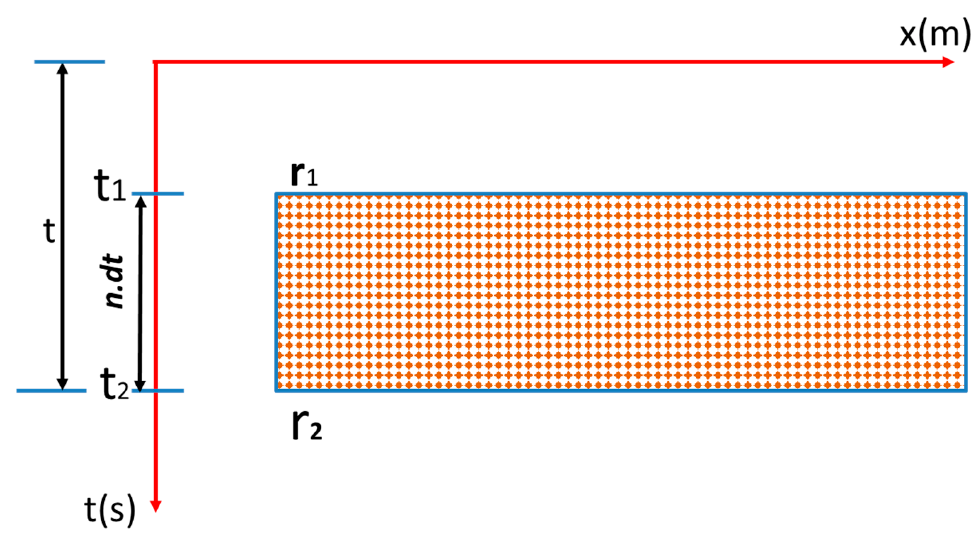
Figure 6. A two-layer reflectivity model.